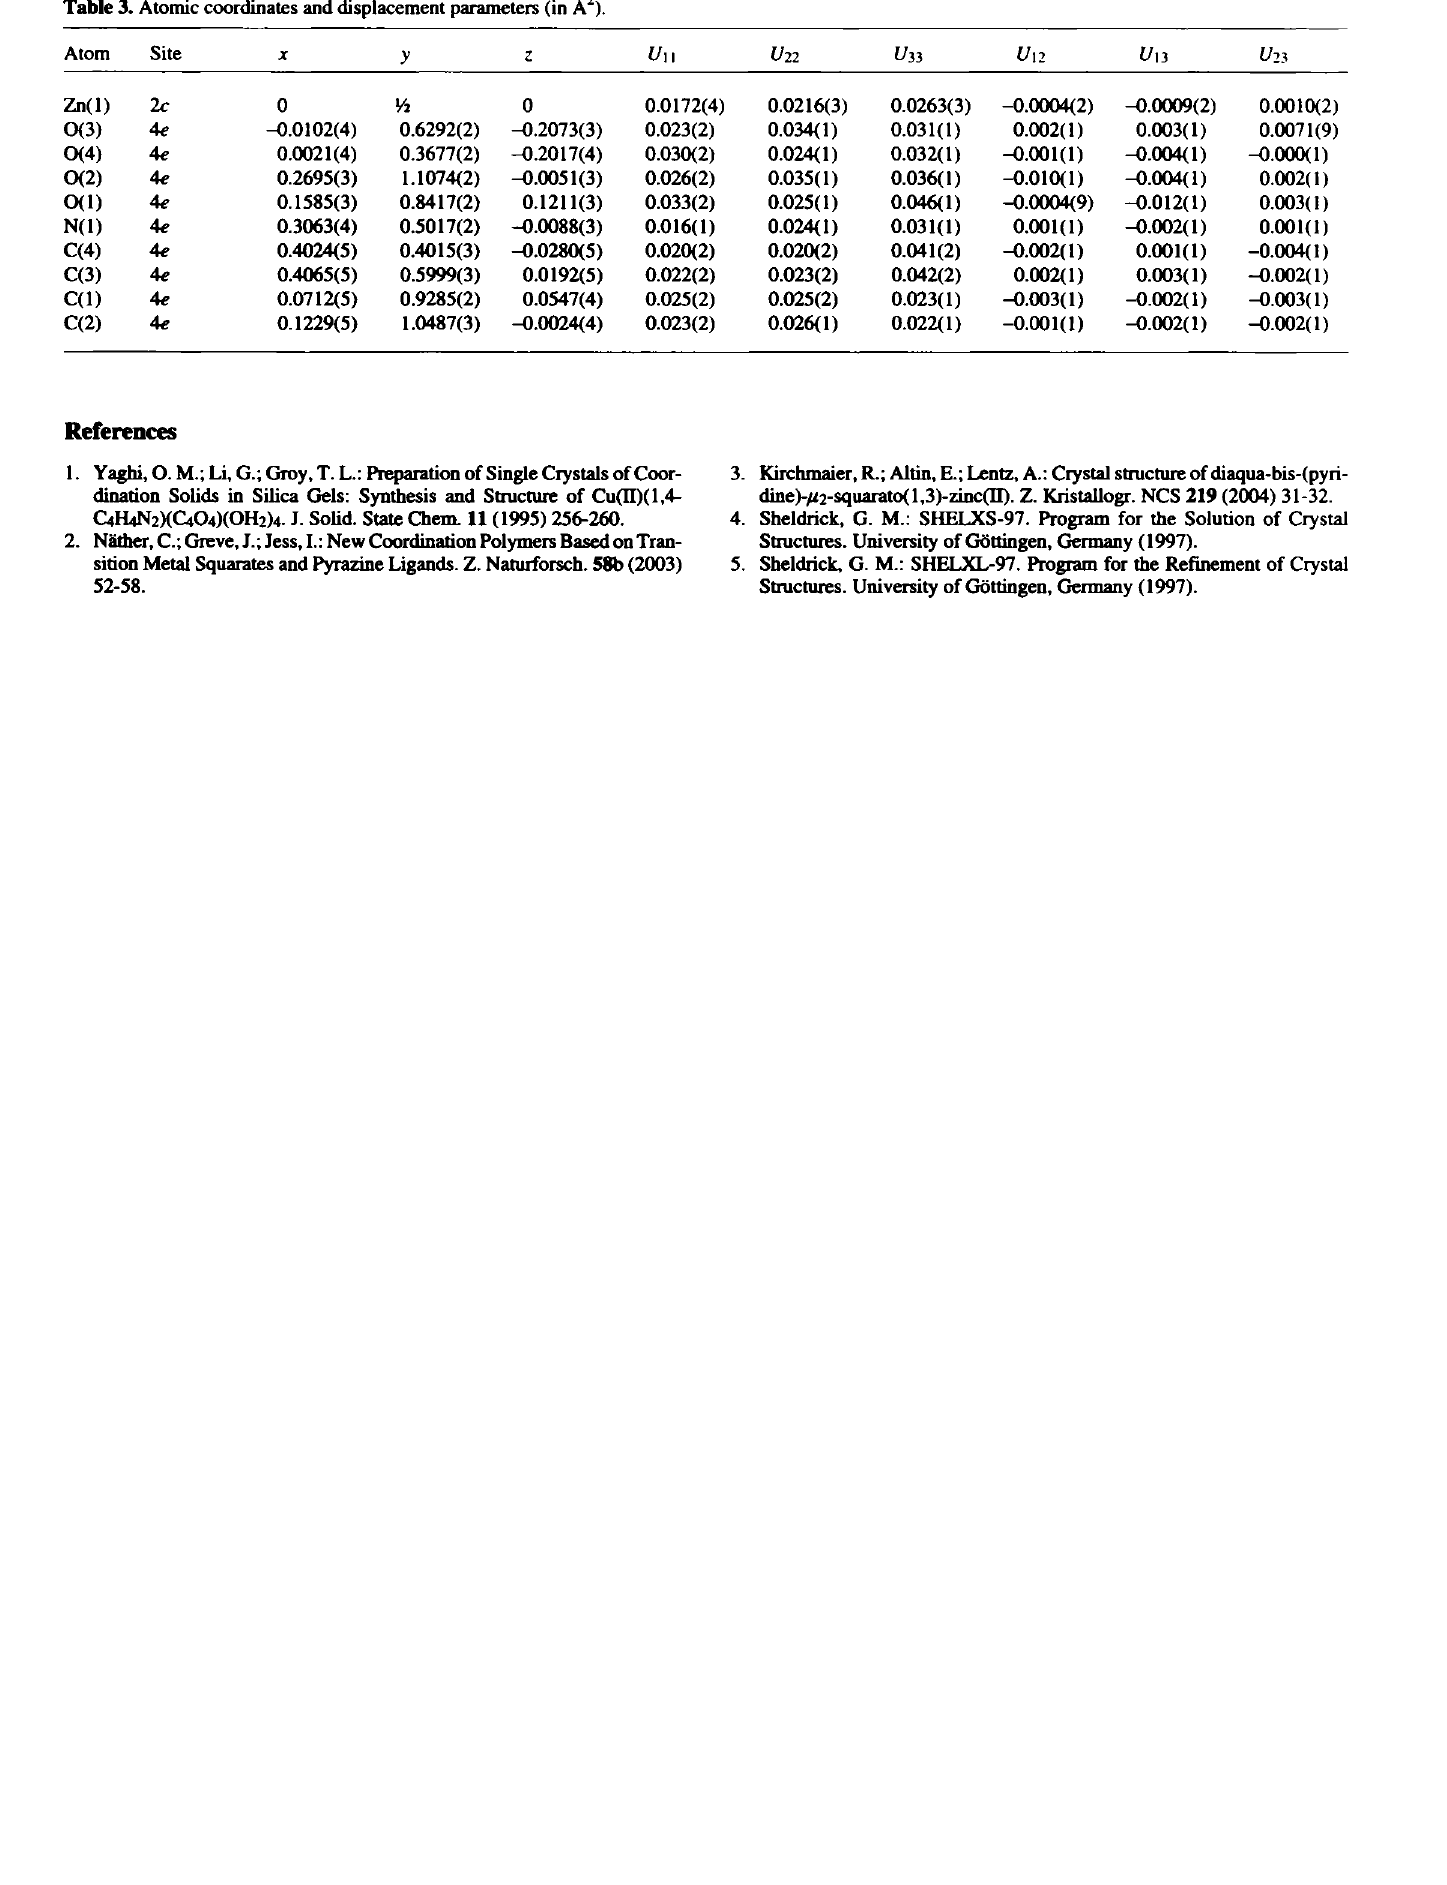
Table 3. Atomic coordinates and displacement parameters (in À 2